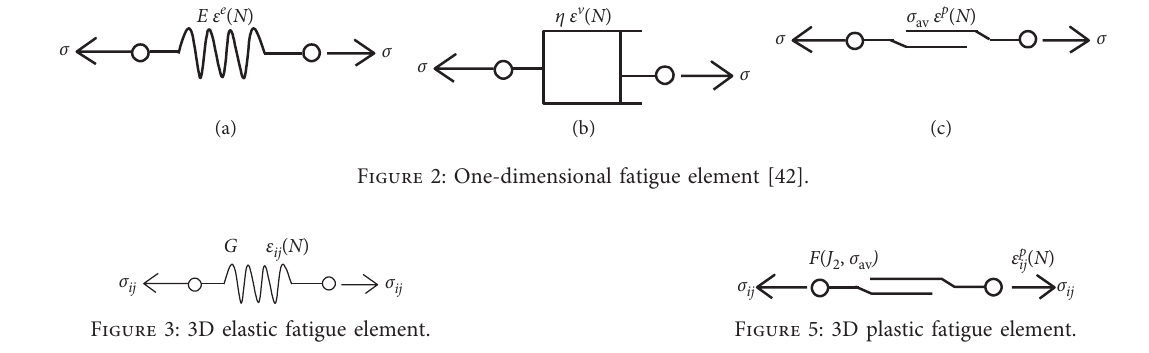
Figure 3: 3D elastic fatigue element.